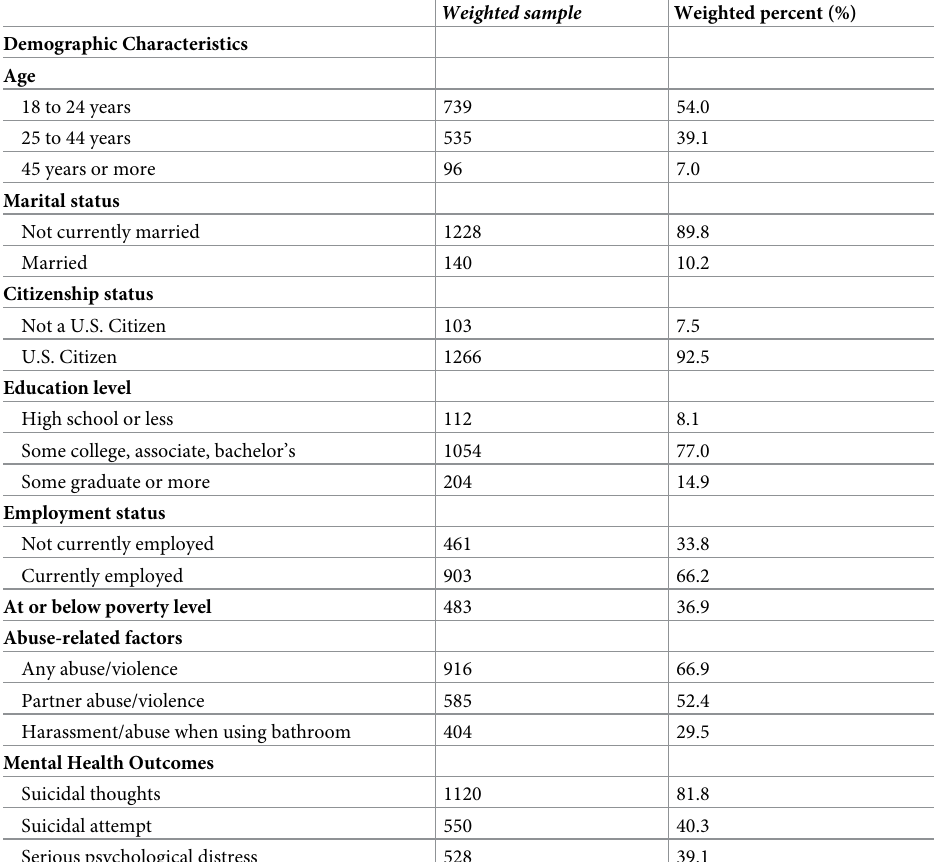
Table 1. Characteristics of study sample